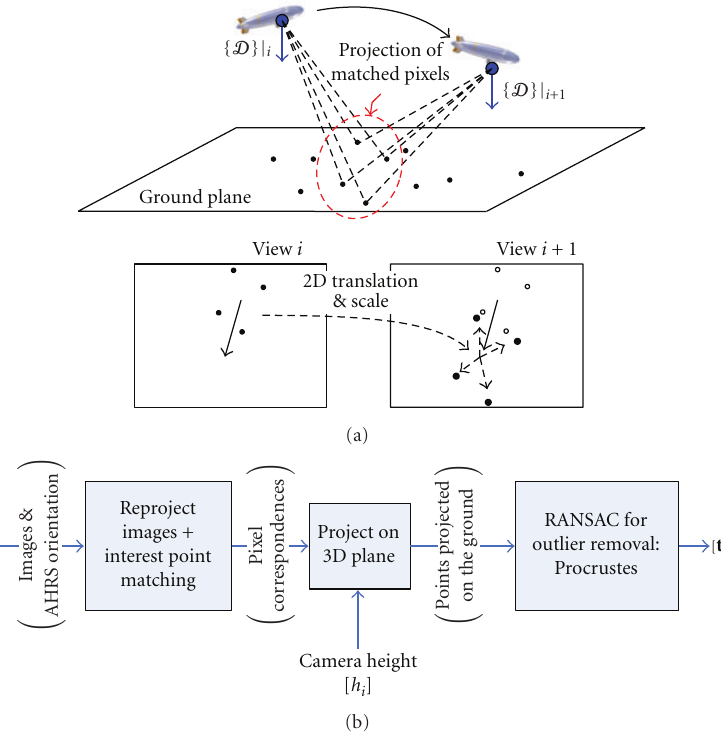
Figure 5: Finding the translation between successive camera poses by 3D scene registration.